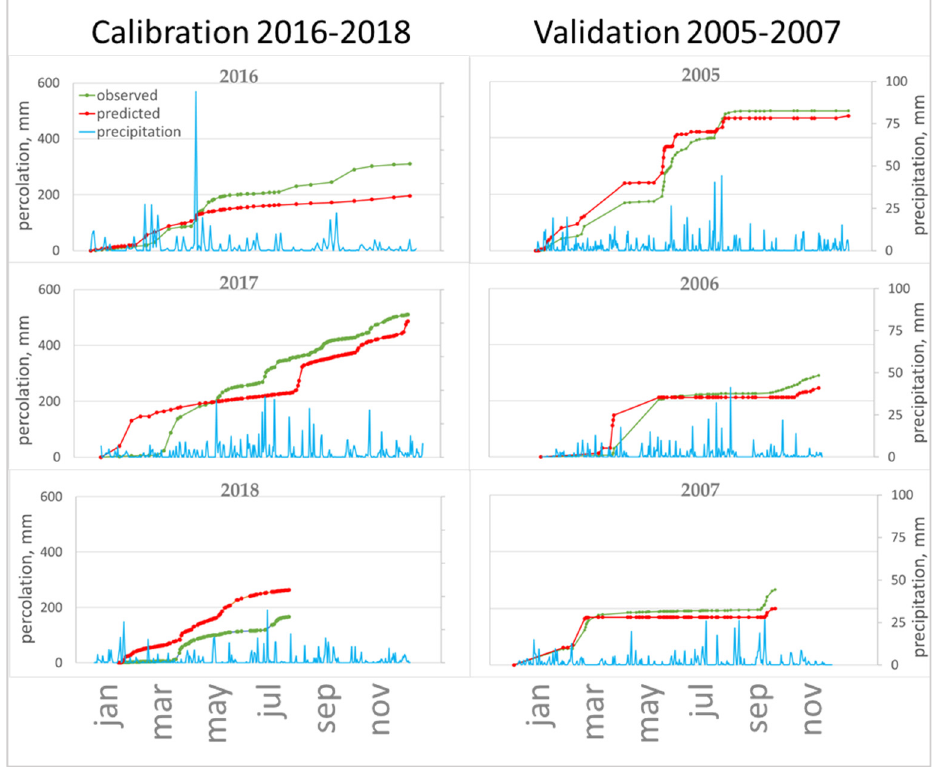
Figure 4. Observed and predicted percolation, precipitation for calibrated and validated period. Table 7. The initial input parameters of pesticide and the range of changes during calibration (in brackets). Horizon